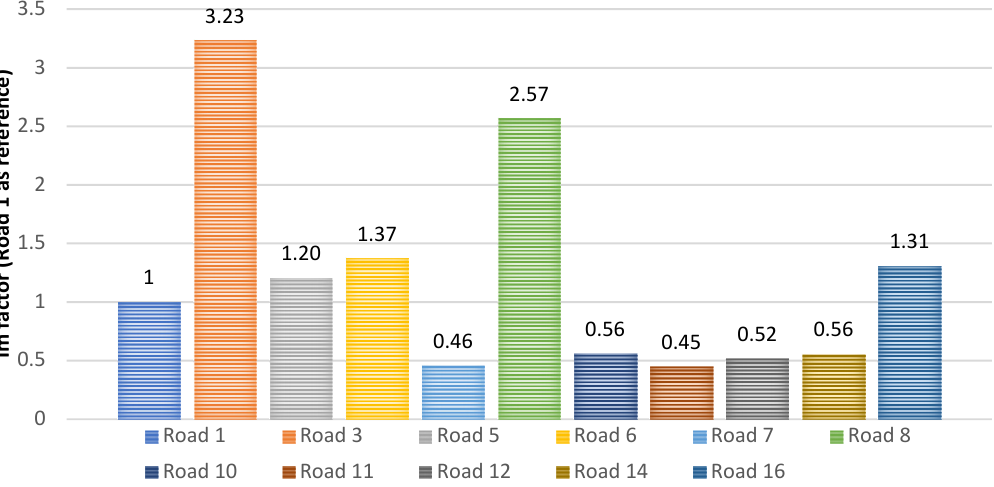
Figure 12. Vertical loads on the vehicle frame at the front end.